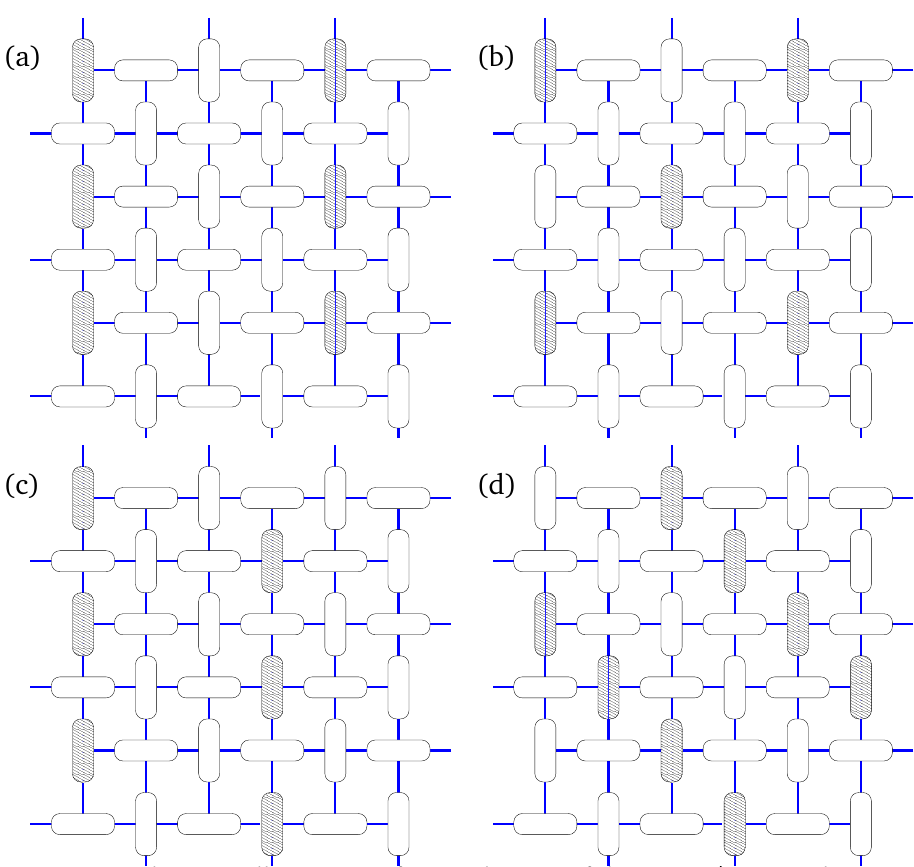
Figure 8: A schematic illustration of ground states of the spin-1 / 2 Heisenberg model on the Shastry-Sutherland lattice emergent in a low-field region as fractional magne- tization plateaux: (a)-(b) stripe and checkerboard configuration for 1 / 8-plateau [ 57 ] ( see Appendix C for other degenerate configurations); (c) 1 / 6-plateau; (d) 1 / 4-